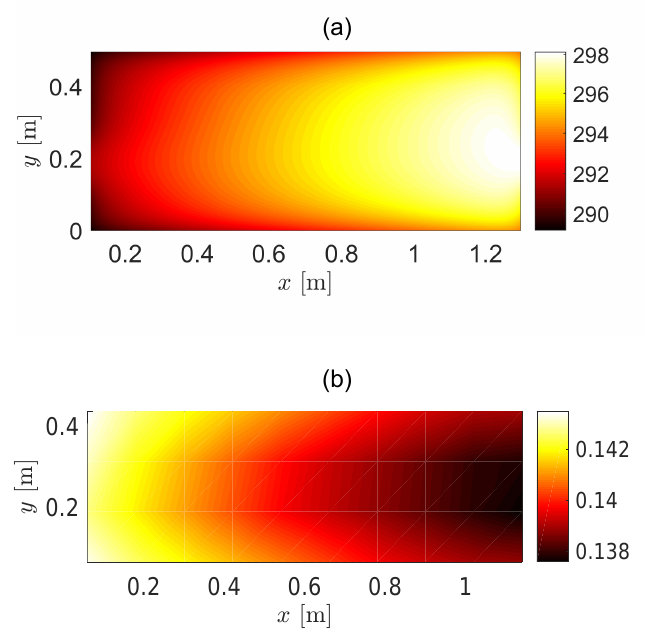
Figure 6. Spatial distribution of ( a ) the cell temperature, T c , and of ( b ) the electrical performance, η , for ˙ v = 600